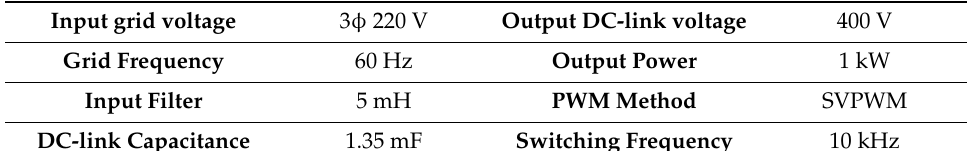
Figure 11. Regions of the proposed three tolerant control method cases on the space vector diagram.